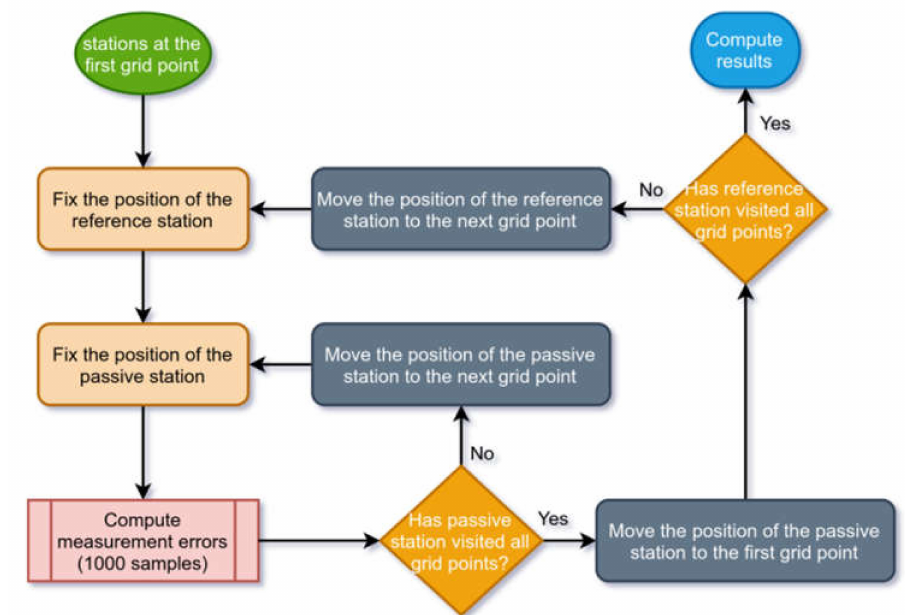
Figure3. Basicproceduretogathermeasurementsinboththereferenceandpassivestations, accordingto the WiFi Passive TDOA approach.